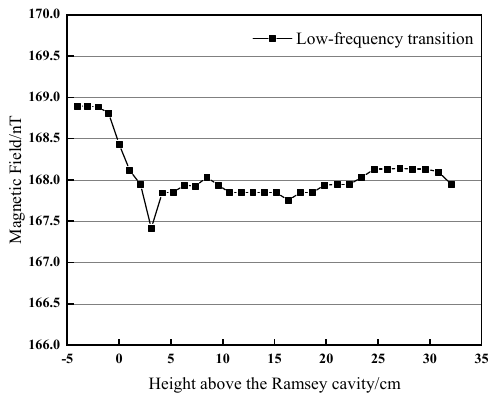
Figure 7. Map of the magnetic field in and above the Ramsey cavity.